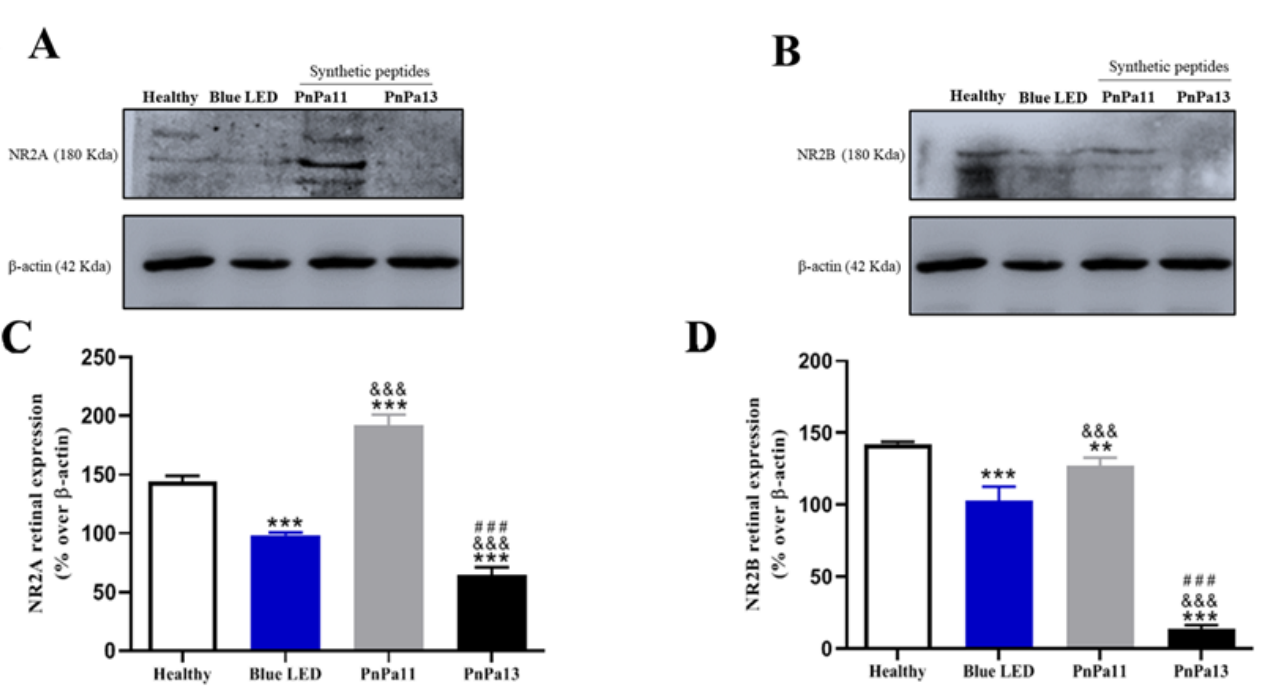
Figure 9. PnPa11 increases retinal expression NR2A and NR2B while PnPa13 reduces this expression in blue LED retinal stress model. Shown are representative immunoblots for (A) NR2A and β-actin expression (upper panel). (B) NR2B and β-actin expression (upper panel). Both expressions levels were performed in retina of healthy group, blue LED, or treated with PnPa11 (1.25 µg/mL) or PnPa13 (1.25 µg/mL) before LED light exposure. About 100 mg of cell lysate were used for each sample. Graphs show the densitometric analysis of NR2A or NR2B normalized to β-actin expression in retina of healthy rats and rats that were Blue LED exposed (vehicle-treated) or treated with PnPa11 (1.25 µg/mL) or PnPa13 (1.25 µg/mL) before LED light exposure. Data represent the means ± SD of four independent experiments (healthy and PnPa11) and three independent experiments (Blue LED and PnPa13), expressed as percentage of basal NR2A or NR2B phosphorylation. * Significant differences as compared with healthy group (*p < 0.05). & Significant differences as compared with Blue LED ( & p < 0.05). #Significant differences as compared PnPa11 with PnPa13 ( # p < 0.05). Analysis was carried out using two-way ANOVA followed by Bonferroni post-